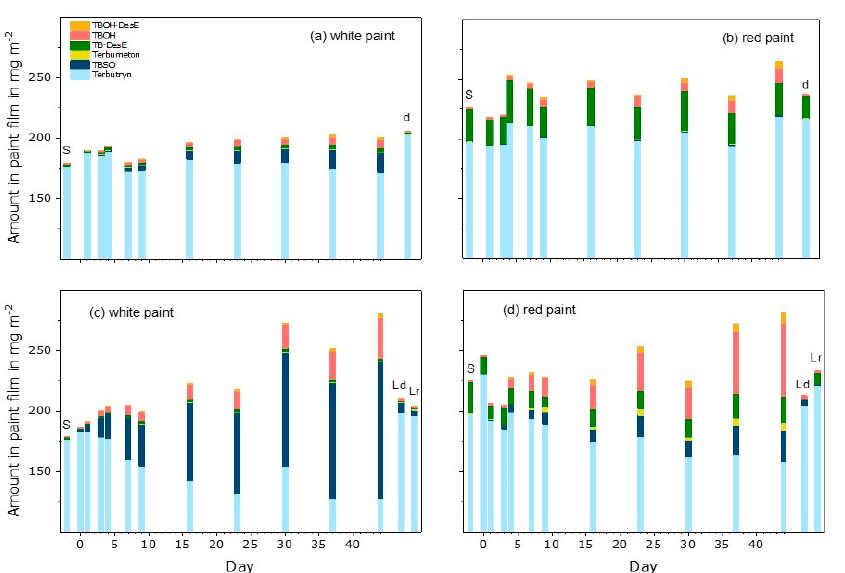
Figure 5. Amounts of terbutryn and transformation products detected in paint extracts. Upper row: test specimens were exposed to UV radiation at 40 ◦ C; lower row: test specimens were exposed to UV radiation at 40 ◦ C and water contact during immersion cycles. Extraction was performed after the immersion cycles. S: original amount detected in test specimens before start, d: test specimen was reversed in the sample holder, Ld: leaching test was performed with test specimens that were reversed in the sample holders (1 immersion cycle), Lr: leaching test was performed with test specimens that were stored at room temperature in the dark (10 immersion cycles). Each column represents mean values from two independently analyzed test specimens.